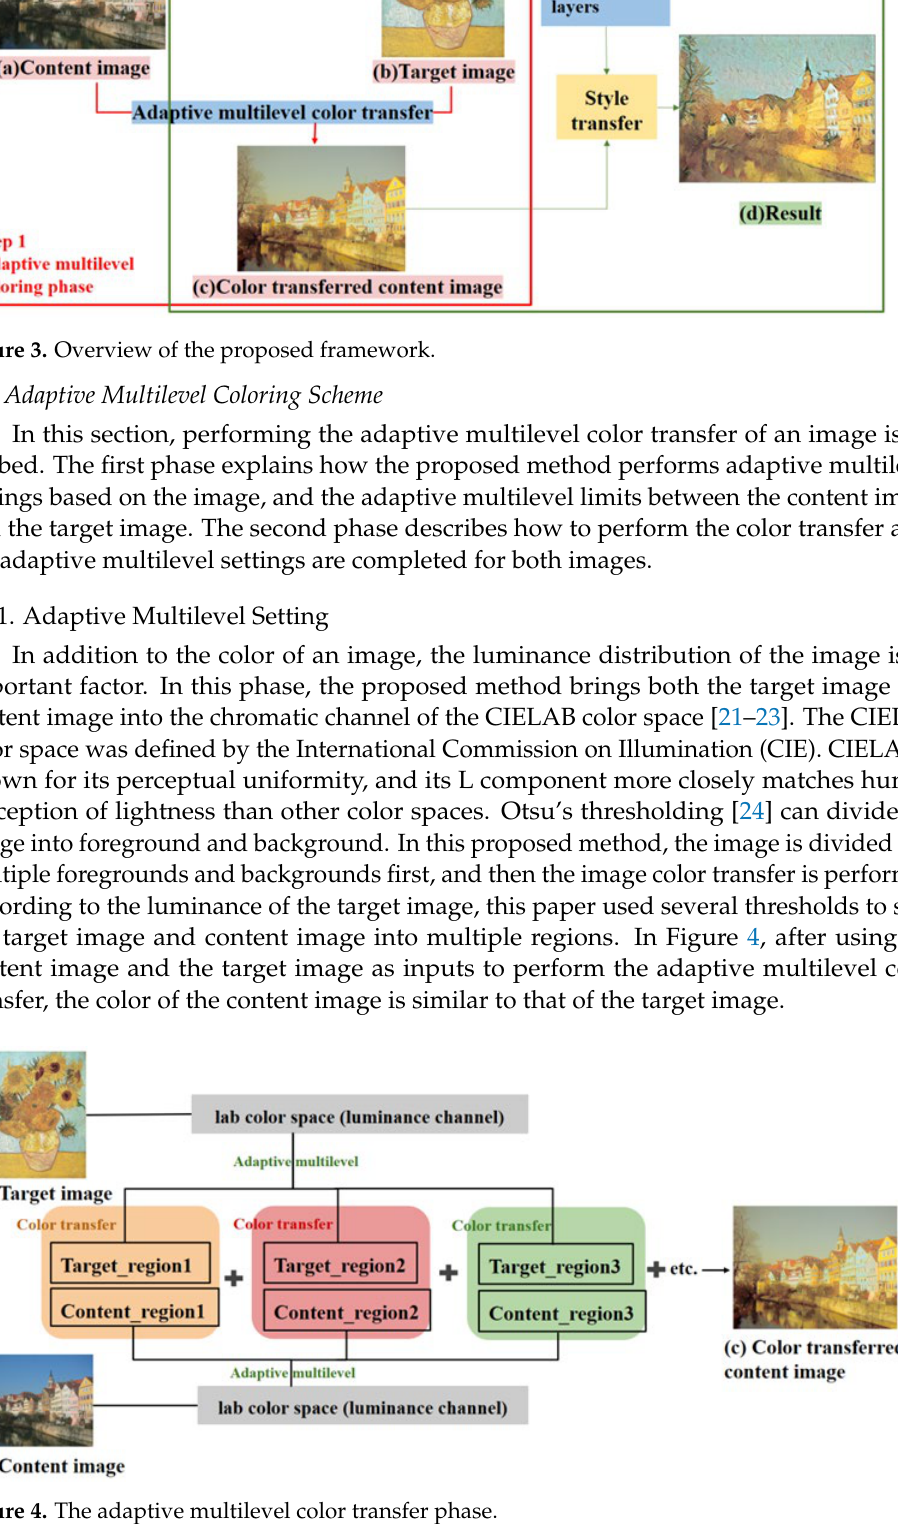
Figure 4. Overview of the proposed framework. Figure 4. The adaptive multilevel color transfer